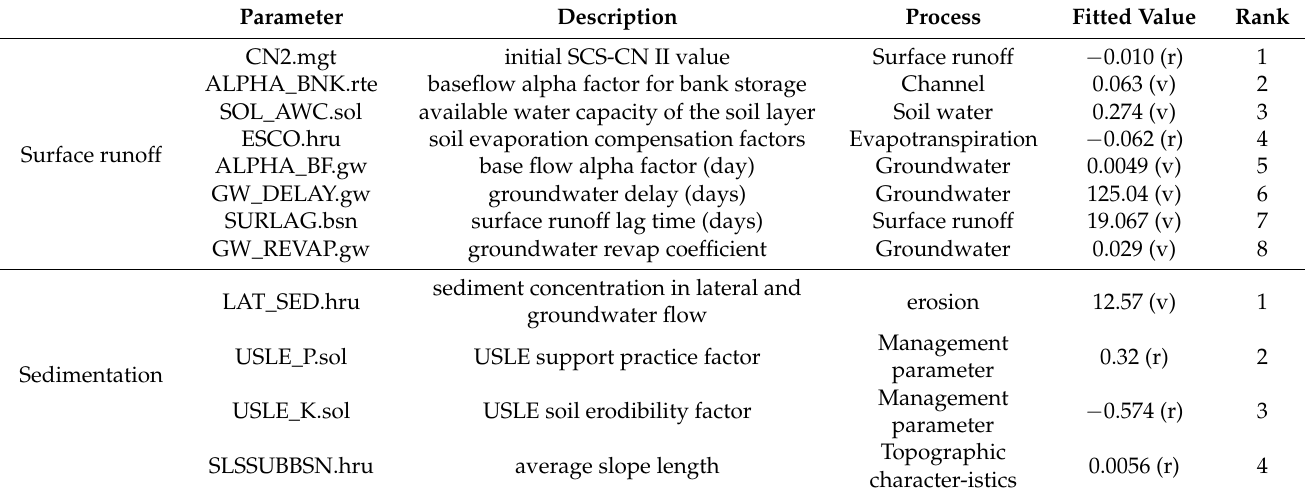
Table 2. Sensitivity analysis of streamflow and sediment yield calibration parameters for